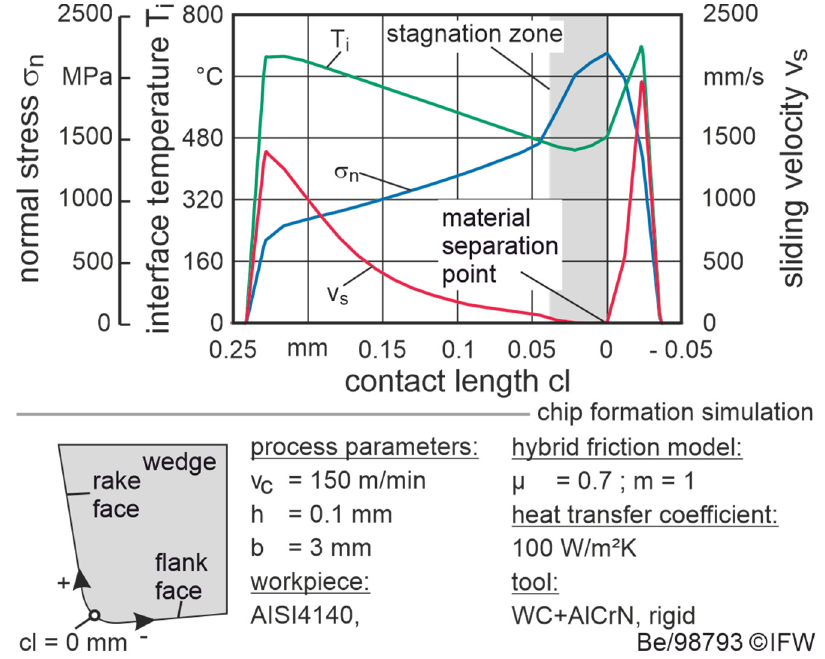
Figure 6. Simulated tool load during machining of AISI4140.